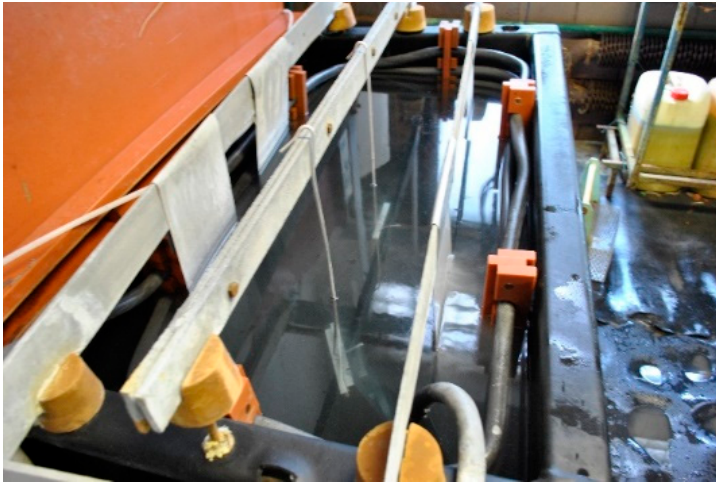
Figure 13. Shot of the anodic oxidation process in practical verification.